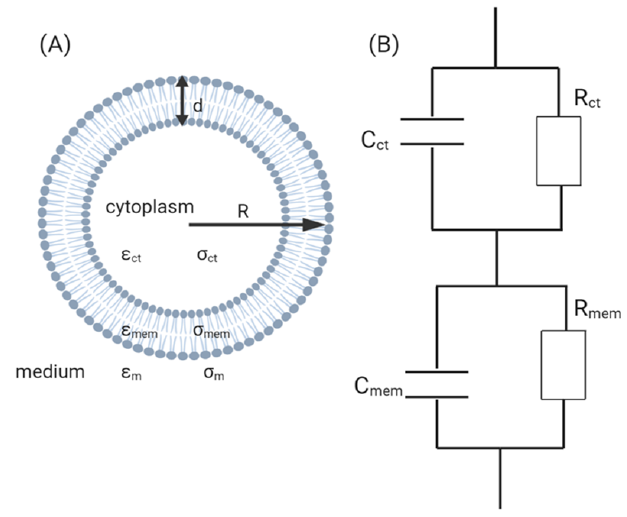
Figure 6. ( A ) A diagram of the electric model of the cell according to Maxwell’s theory of mixtures. ( B ) Equivalent circuit of the single cell model [26,48].